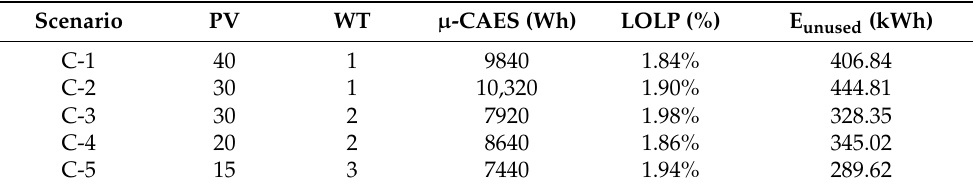
Table 2. Scenarios of hybrid system with micro-CAES satisfying the preset criteria.